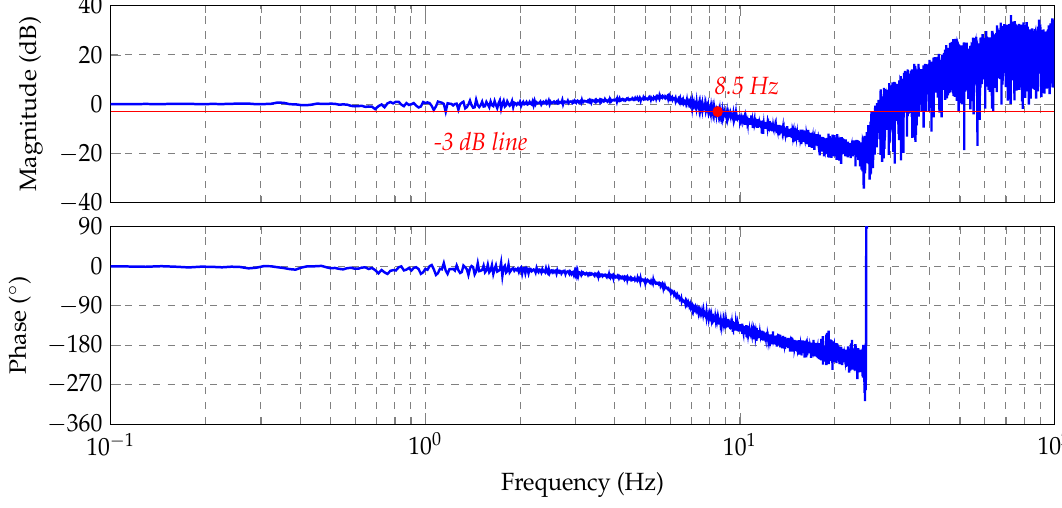
Figure 10. Bode plot of the force tracking test with chirp input ( f = 0.1–100